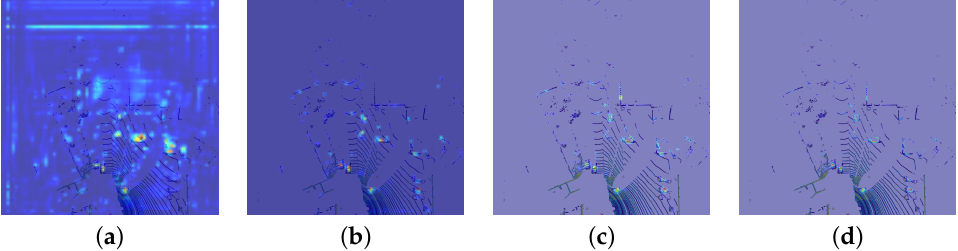
Figure 9. In this figure, we compare different input pointcloud mask resolutions assumed while casting points to BEV: ( a ) no mask, ( b ) 80, ( c ) 160, and ( d ) 640 pixels. Without a mask, the generated CAM is noisy and imprecise. Application of masks filters the noise and increases the level of detail near the input pointcloud data. However, at higher mask resolutions, CAMs become too grained and thus not valid for a human visualization.